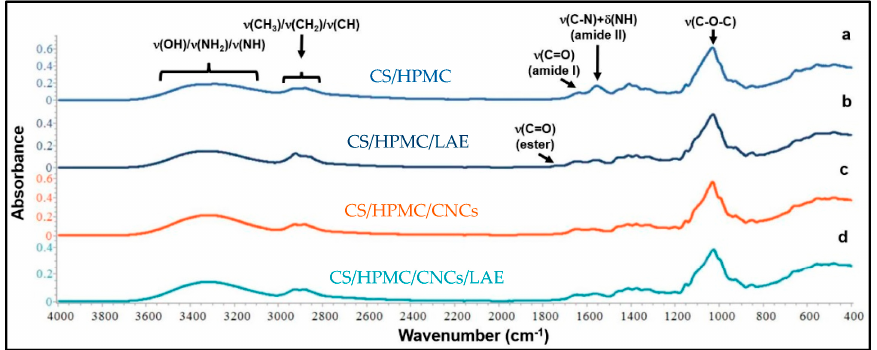
Figure 7. ATR/FT − IR spectra of films based on (a) chitosan/hydroxypropyl methylcellulose blend (CS/HPMC), (b) CS/HPMC/LAE, (c) CS/HPMC/CNCs, and (d) CS/HPMC/CNCs/LAE.